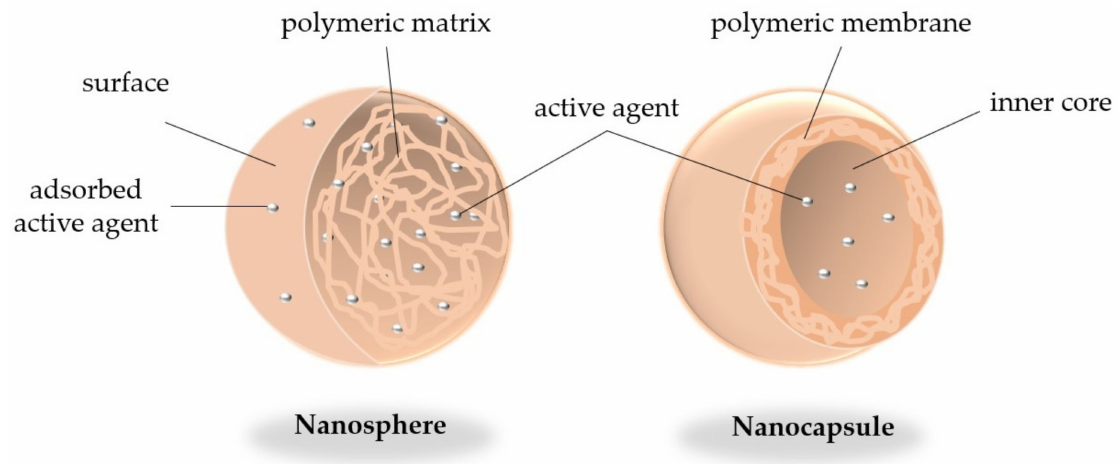
Figure 2. Nanospheres with the active agent adsorbed and dispersed on the polymeric surface ( left ); and nano-capsules with the active agent confined in the core surrounded by a polymeric membrane ( right